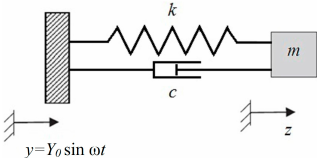
Figure 1. Mechanical scheme of vibrational energy harvesting. The generator frame is fixed on the vibration source y ( t ). vibration source y ( t